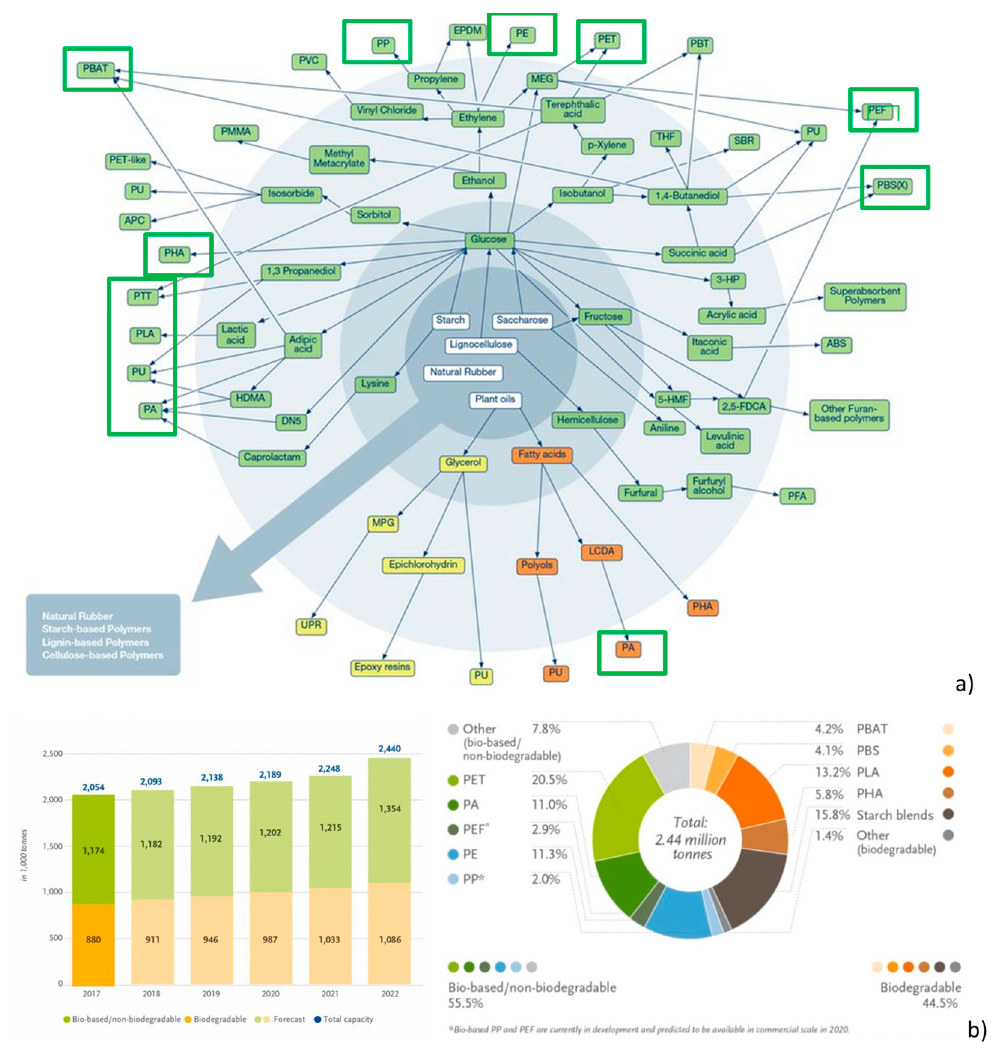
Figure 4 . Commercially realized pathways from biomass via different building blocks and monomers to bio-based polymers ( a ); estimated global production capacities of bioplastics (biodegradable, bio- based/non-biodegradable) for 2022 by material type ( b )